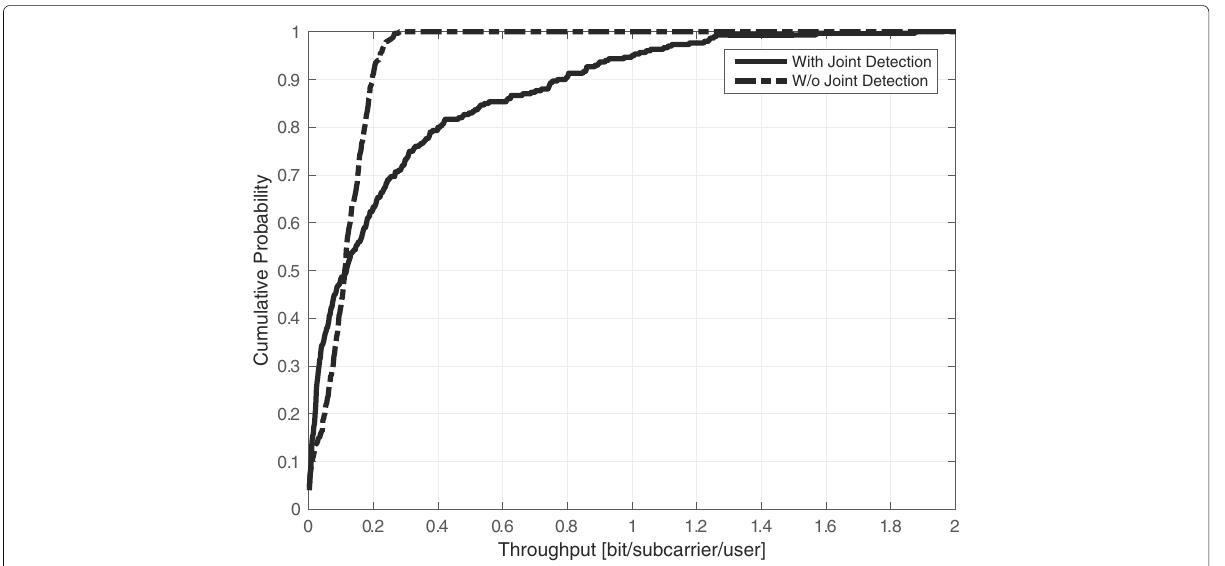
Fig. 5 System throughput performance in macro cell (10 users/sector)